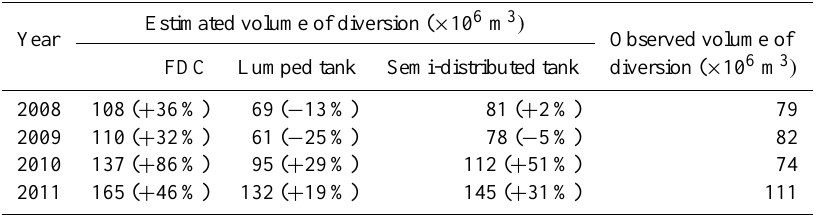
Table 6. Estimated impairment and observed canal diversions at Sevier River near Kingston from April to September. The numbers within parentheses are percent difference from the observed